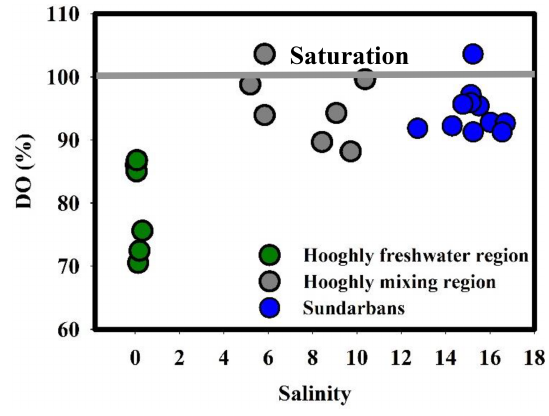
Figure 2. Percent saturation of DO–salinity relationship in the Hooghly–Sundarbans